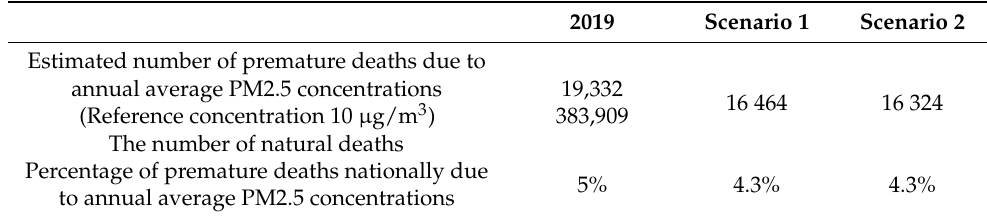
Table 4. Estimated number of premature deaths nationally due to annual average PM2.5 concentra- tions in 2019 and based forecasts on scenario 1 and scenario 2.